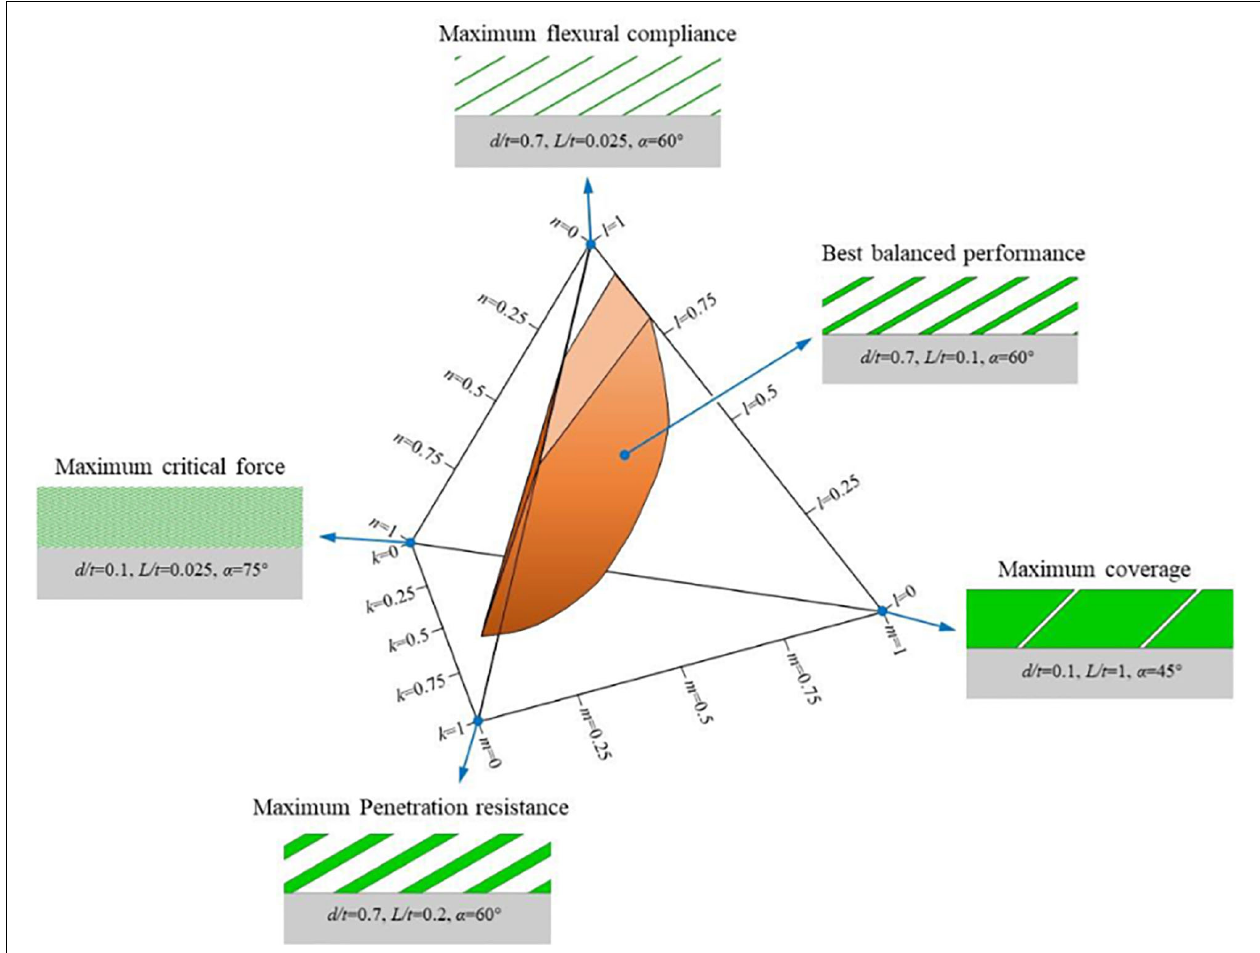
FIGURE 9 | A detailed illustration of scale slant angle, aspect ratio, and scale thickness for optimized flexibility and puncture resistance (Shafiei et al.,